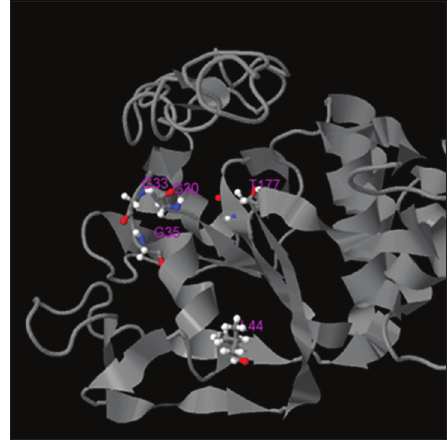
Figure-5: The prediction structure of enzyme commission active site in Trypanosoma evansi multidrug resistance protein